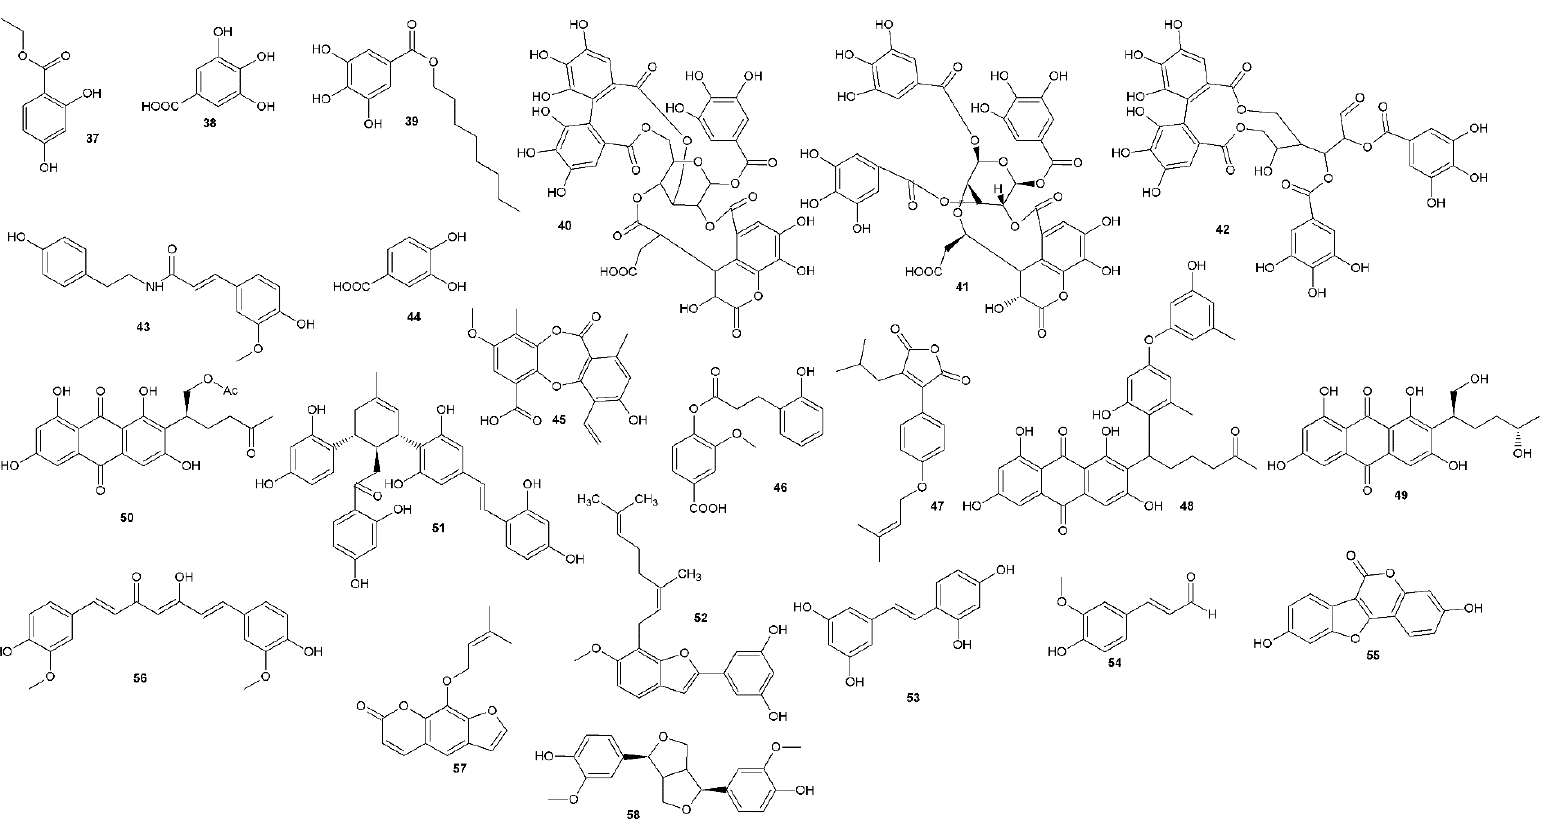
Figure 2. Phenolic compounds with antiherpetic activity.